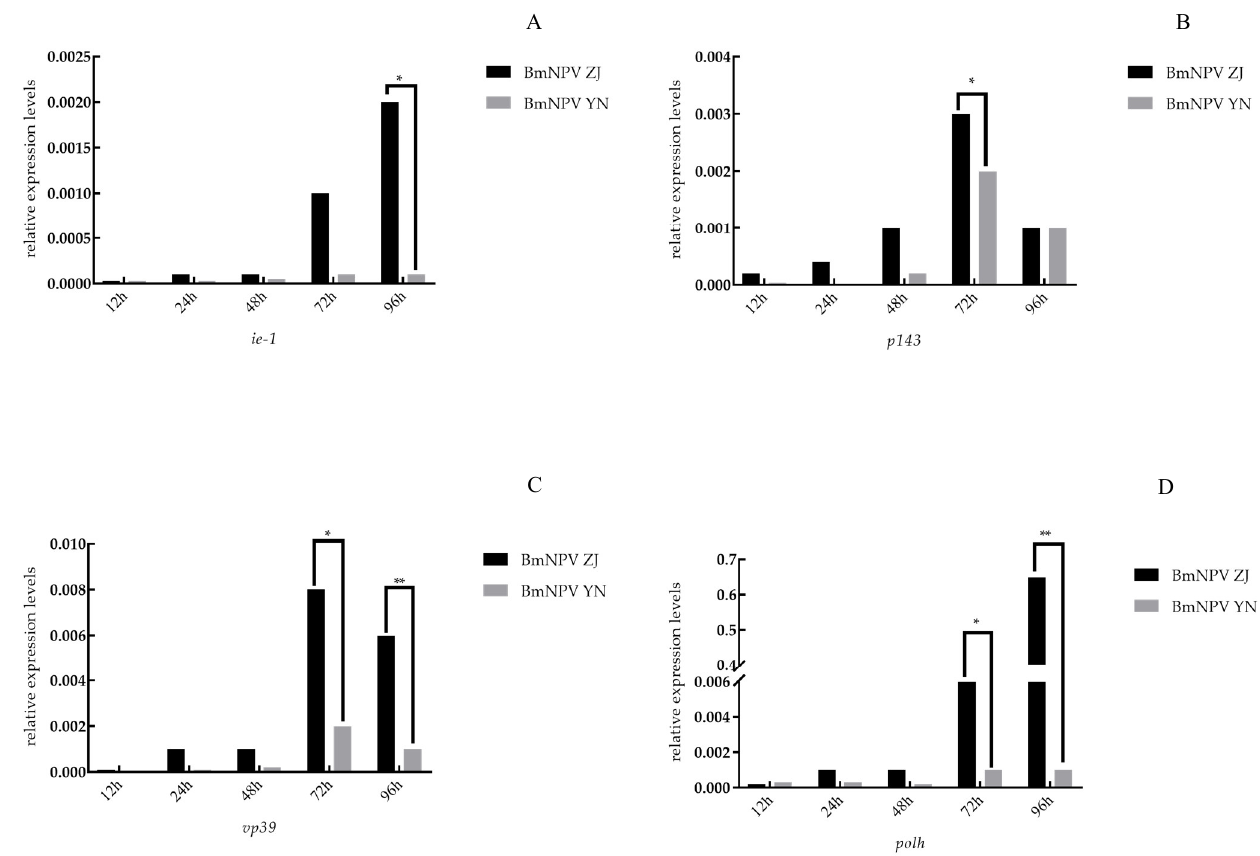
Figure 3. The relative expression of genes of the two BmNPV strains in the midgut of Baiyu larvae: ( A ) ie-1 ; ( B ) p143 ; ( C ) vp39 ; ( D ) polh. Note: “*” represents p < 0.05; “**” represents p < 0.01.